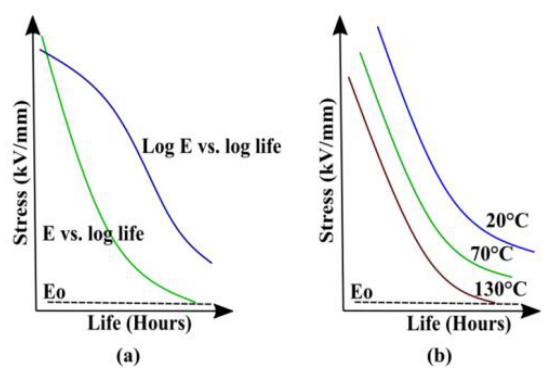
conditions of the insulation.